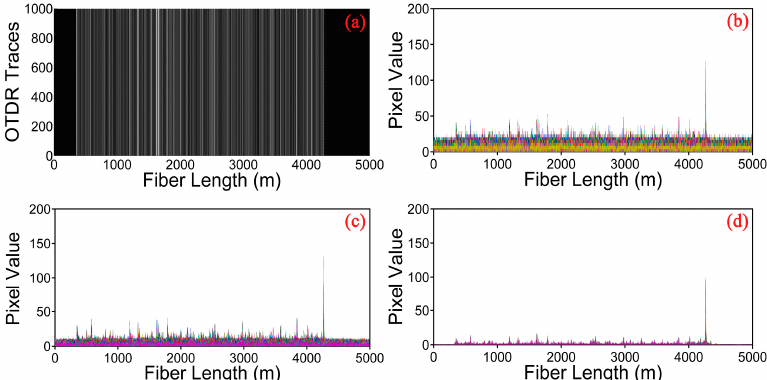
Figure 5. Experiment results of 1 kHz vibration event. ( a ) A gray image constituted by consecutive Rayleigh curves; ( b ) Moving differential method; ( c ) Curvelet denoising method based on the traditional thresholding; ( d ) Curvelet denoising method based on the optimized thresholding. In order to observe the denoising effect intuitively, the SNR for 50 Hz and 1 kHz using different